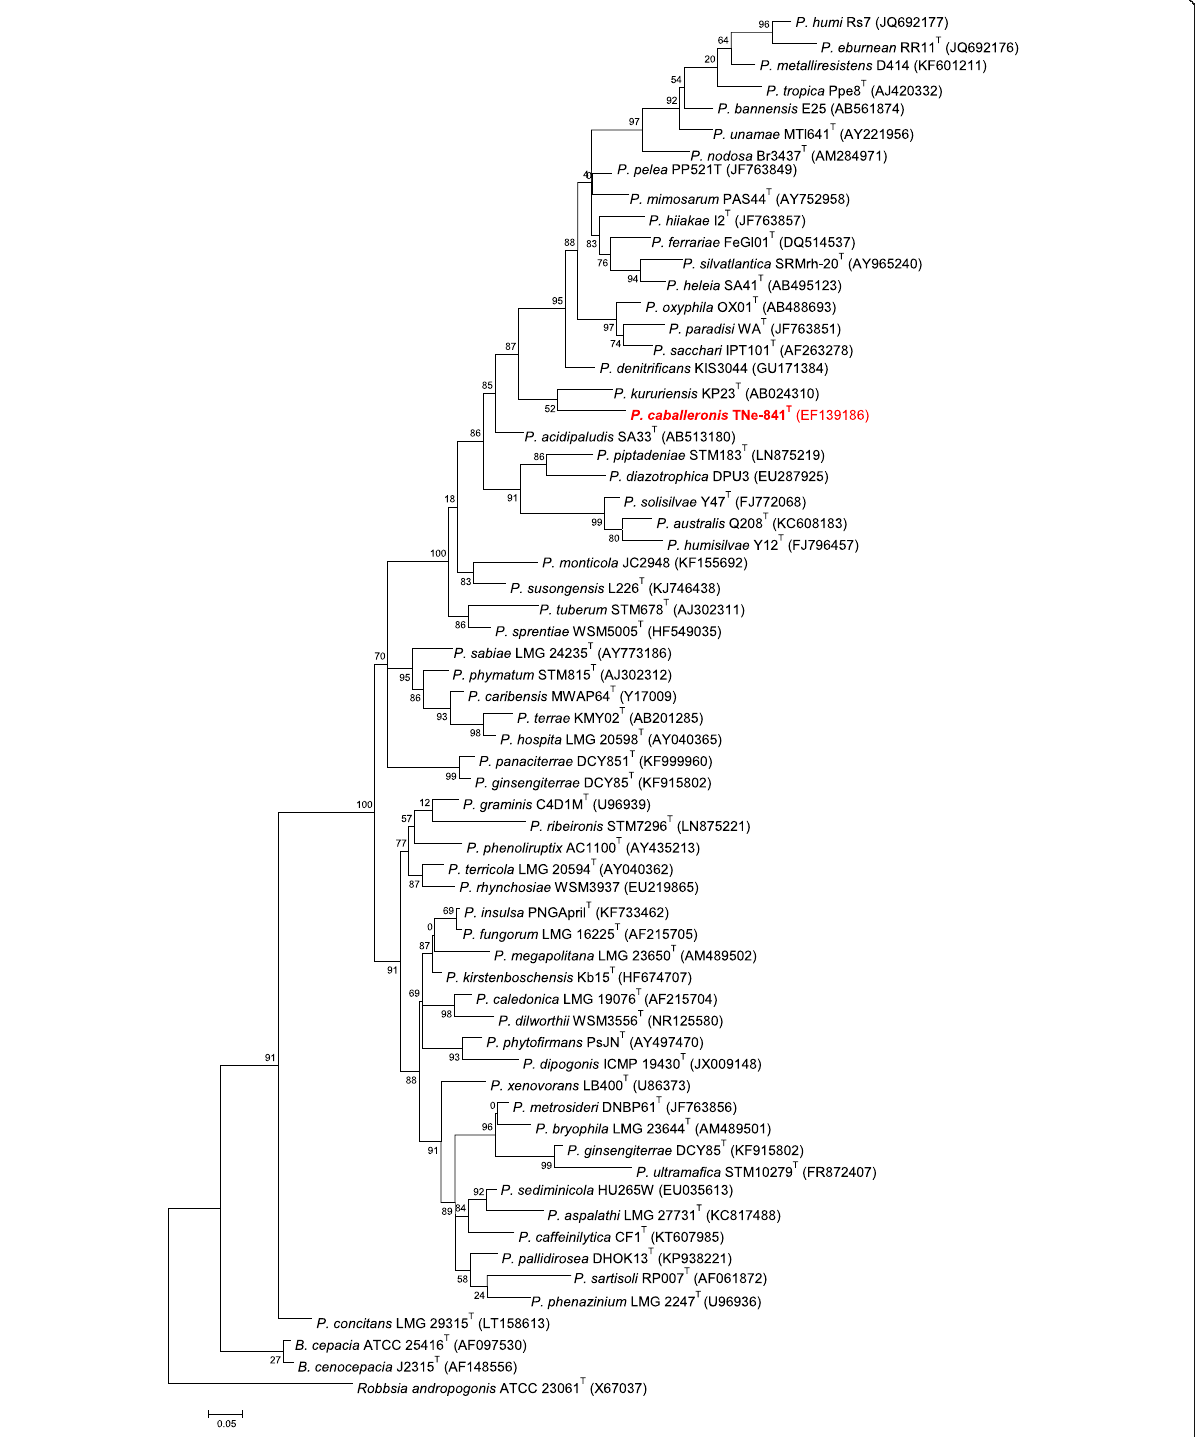
Fig. 1 Phylogenetic tree highlighting the position of Paraburkholderia caballeronis TNe-841 T in relation to other Paraburkholderia species. Burkholderia and Robbsia were used as outgroups. The bar represents the number of expected substitutions per site under the GTR+G model. The sequenced strain is indicated in